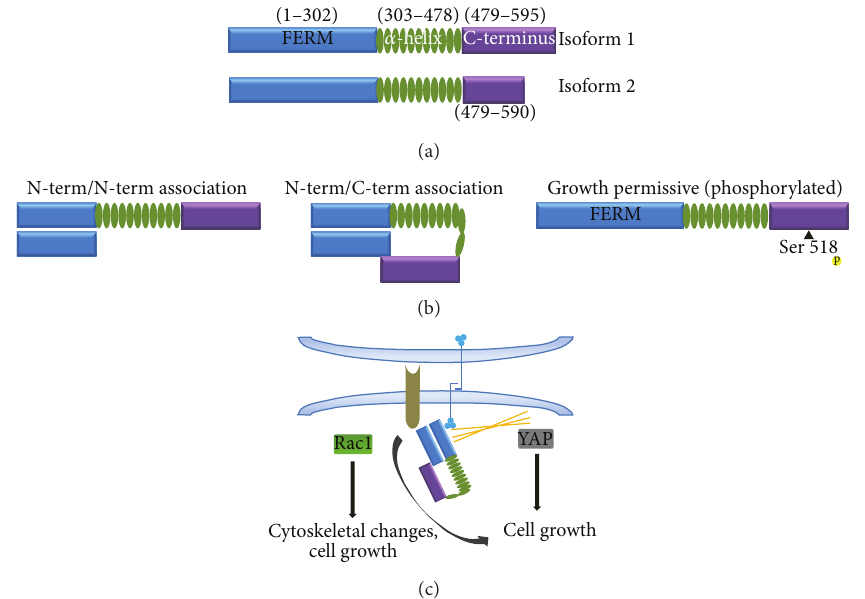
Figure 5: Merlin structure and function. (a) Merlin is a 595- (or 590-) amino-acid protein composed of three structural regions: an amino terminaldomain(FERM),an 𝛼 -helixdomain,andacarboxylterminaldomain(CTD).Therearetwomerlinisoforms. Isoform1containsexon 17 and lacks exon 16. Isoform2 contains exon 16, which inserts11unique c-terminal amino acids followed by a termination codon that prevents the translation of exon 17. (b) Merlin forms an intramolecular complex in which the FERM domain associates with the CTD. Phosphorylation of merlin at Serine-518 results in an open conformation, which inactivates the tumor suppressor activity of merlin. (c) Merlin binds to the actin cytoskeleton, RTKs, and CD44 to form proper adherens junctions. It also inhibits RAC1 and YAP activity, which are important for normal growth